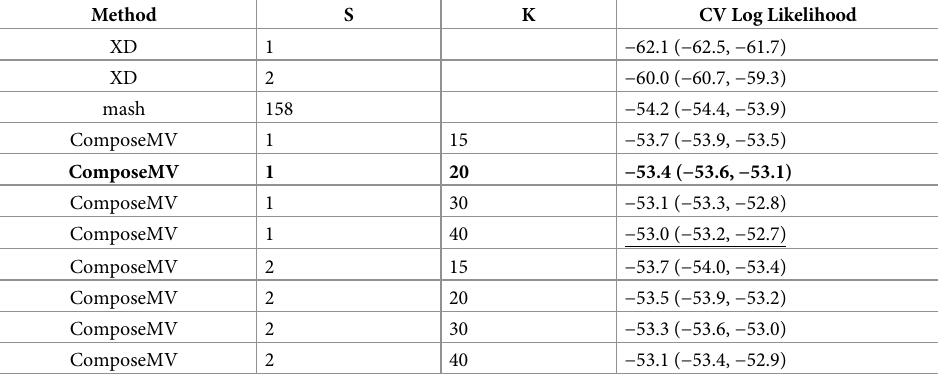
Table 8. Comparison of cross-validated log likelihood across MV models on the IMPC data. The row showing the model used in the main analyses in the paper, M , is highlighted in bold. The largest CV log likelihood is under- main lined. The results shown are the per-sample log likelihood L ð c Þ of (34) averaged across folds c = 1, ... ,10, along with ± 2 CV SEM intervals. Method S K CV Log Likelihood